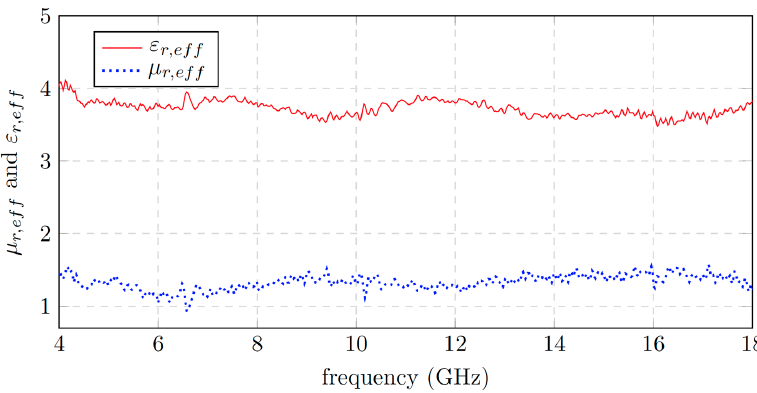
Figure 13. Extracted apparent relative permeability and permittivity of a 0.2 mm pitch ACP, t = 60 µm.